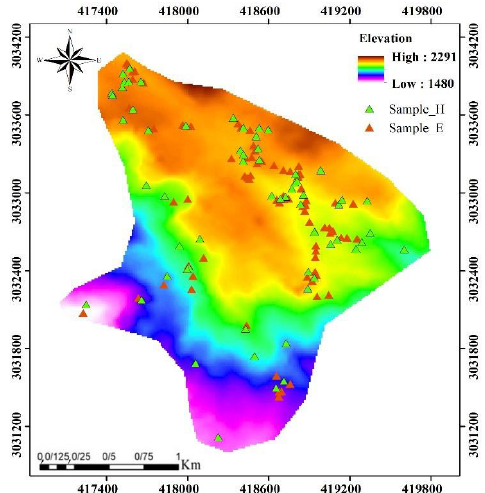
Figure 3. Topographical maps of the study area elevation and samples distribution pattern (Sample_H, trees without dried branches; Sample_E, trees with dried branches).